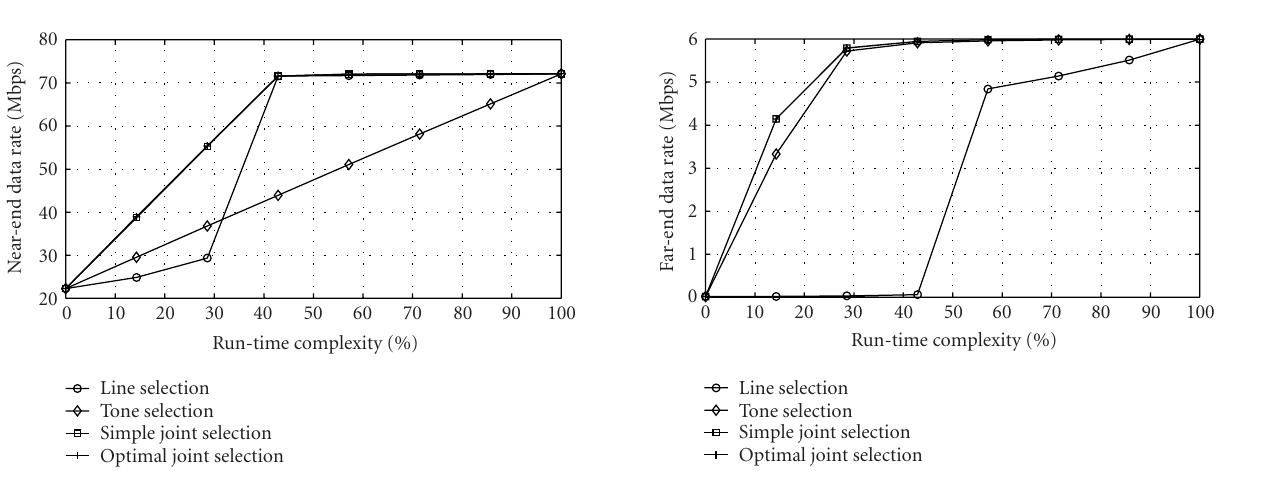
Figure 6: Near-end data rate versus run-time complexity. Figure 7: Far-end data rate versus run-time